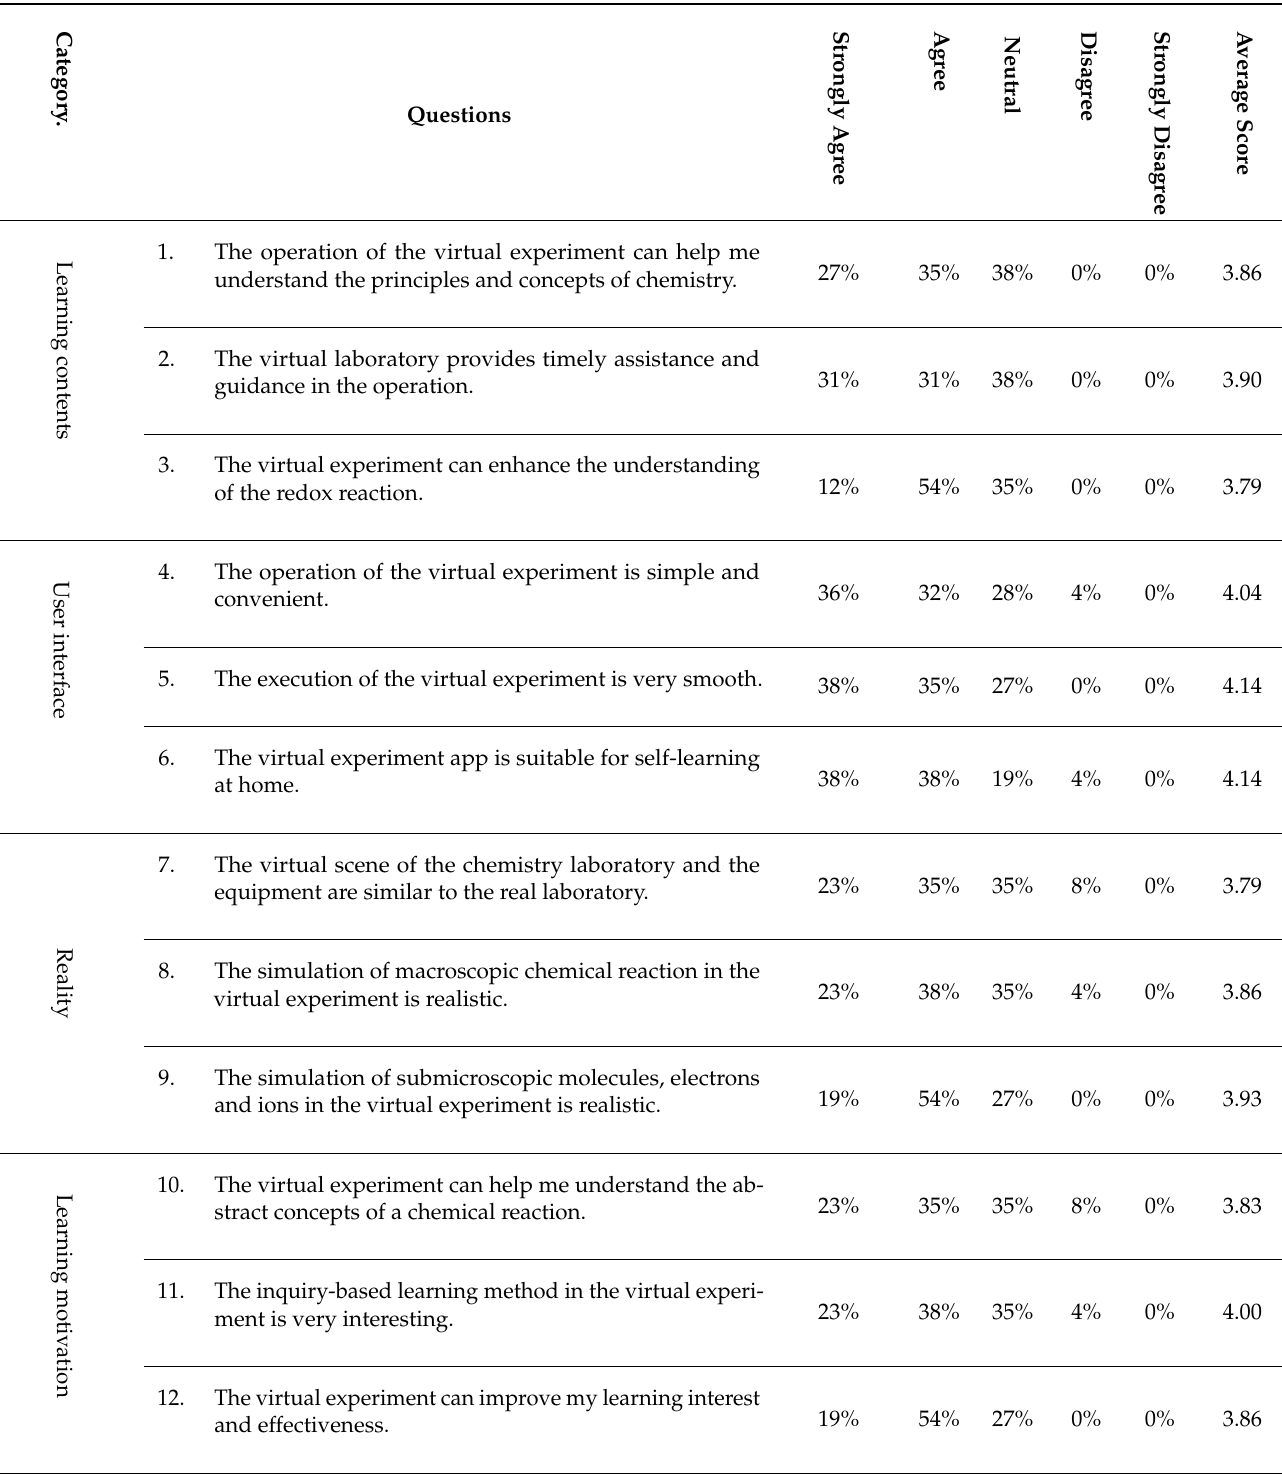
Table 8. Statistical results of questionnaire